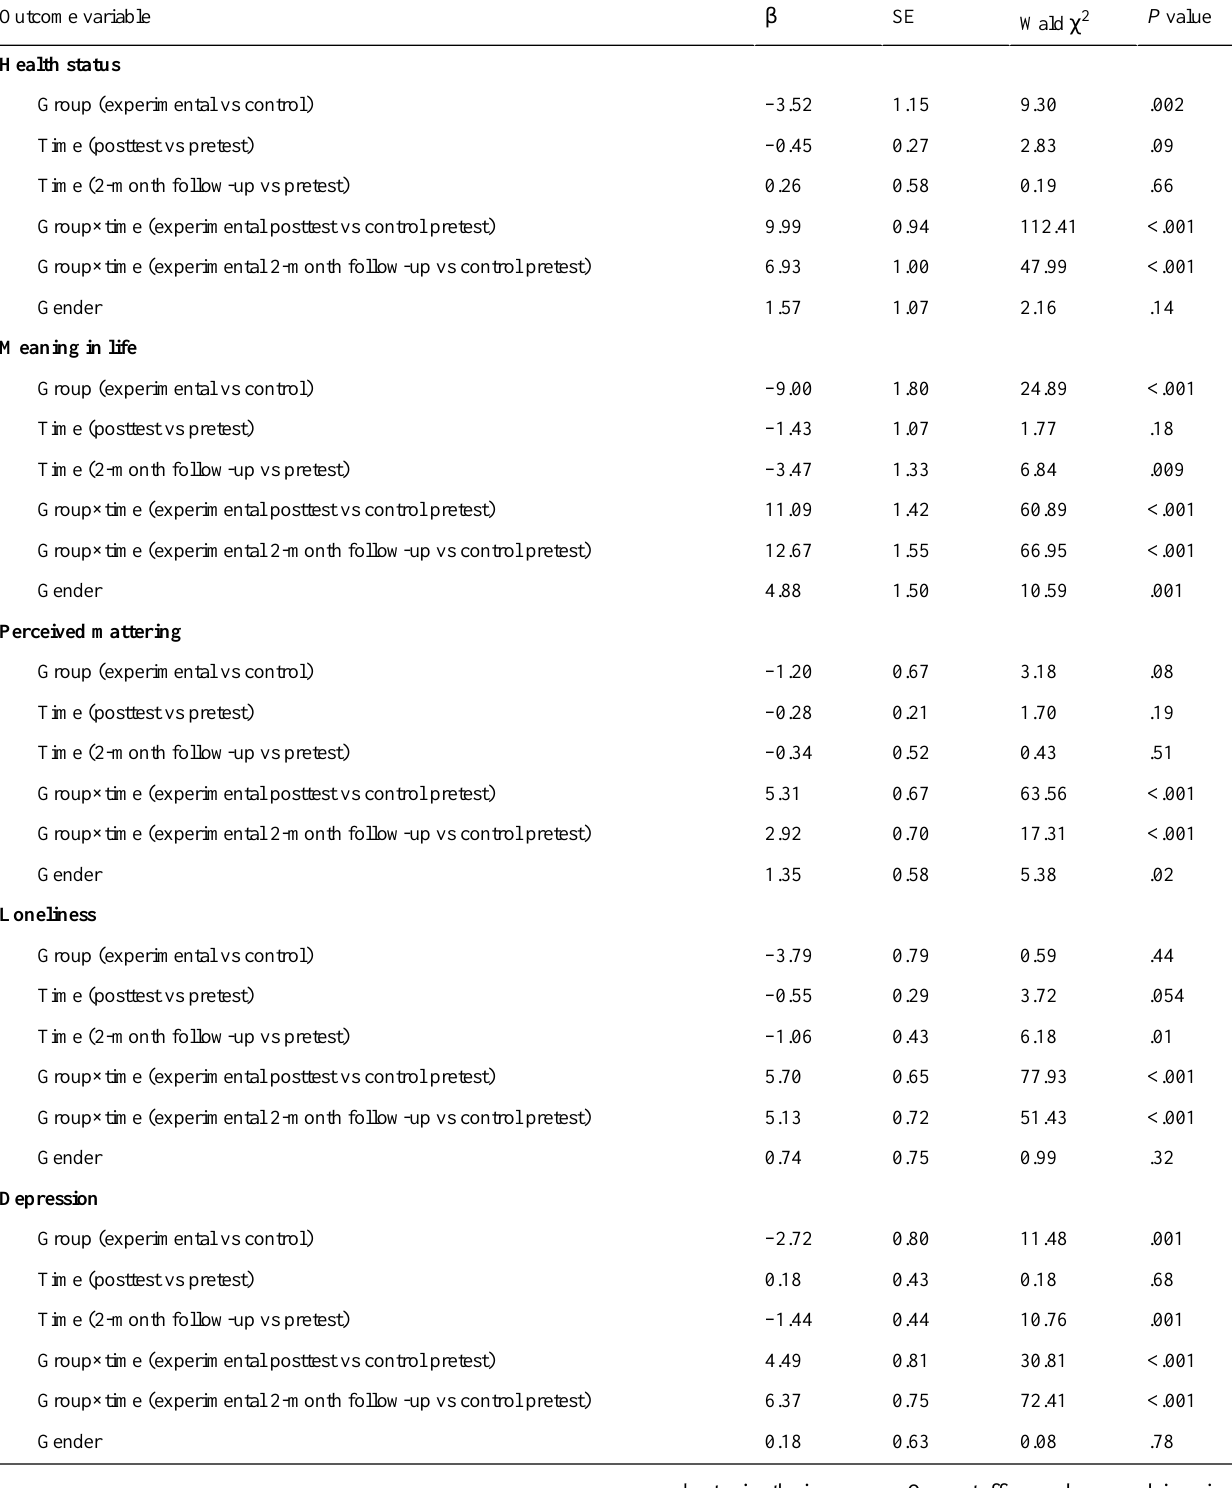
Table 1. Changes in outcome variables between the experimental group and the control